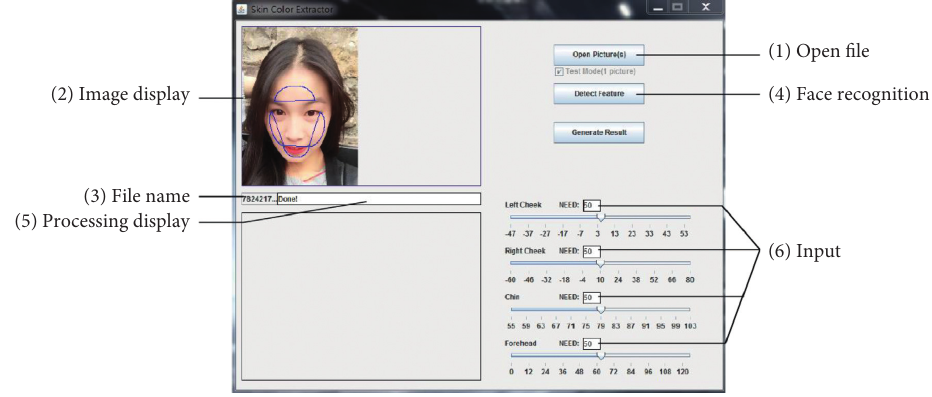
Figure 2: Instruction for SCE operation.